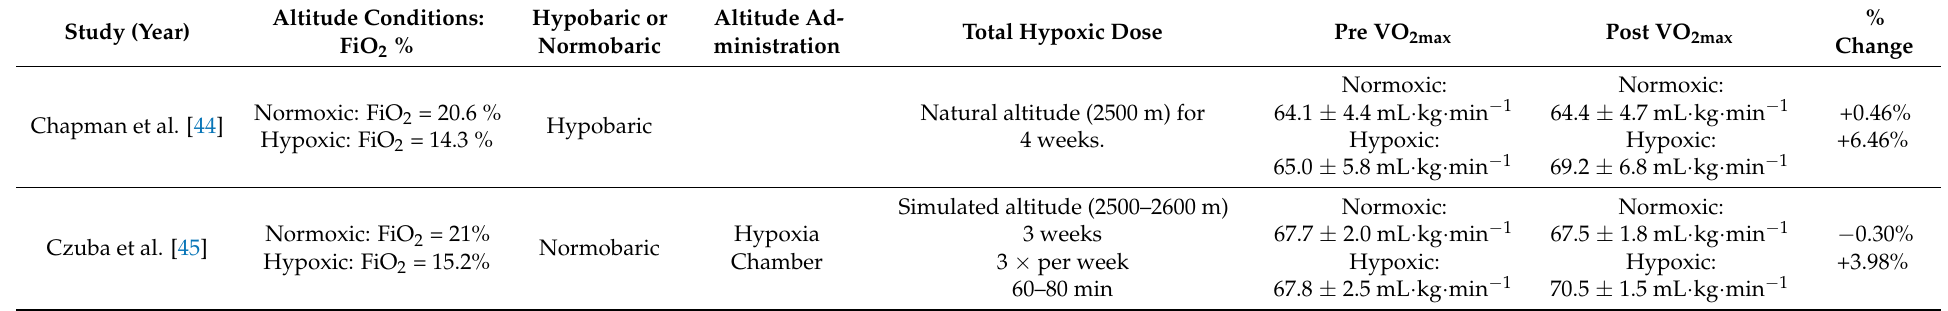
Table 2. Summary of hypoxic training conditions, VO 2max pre/post intervention, % ∆ VO 2max , altitude condition, administration, and total hypoxic